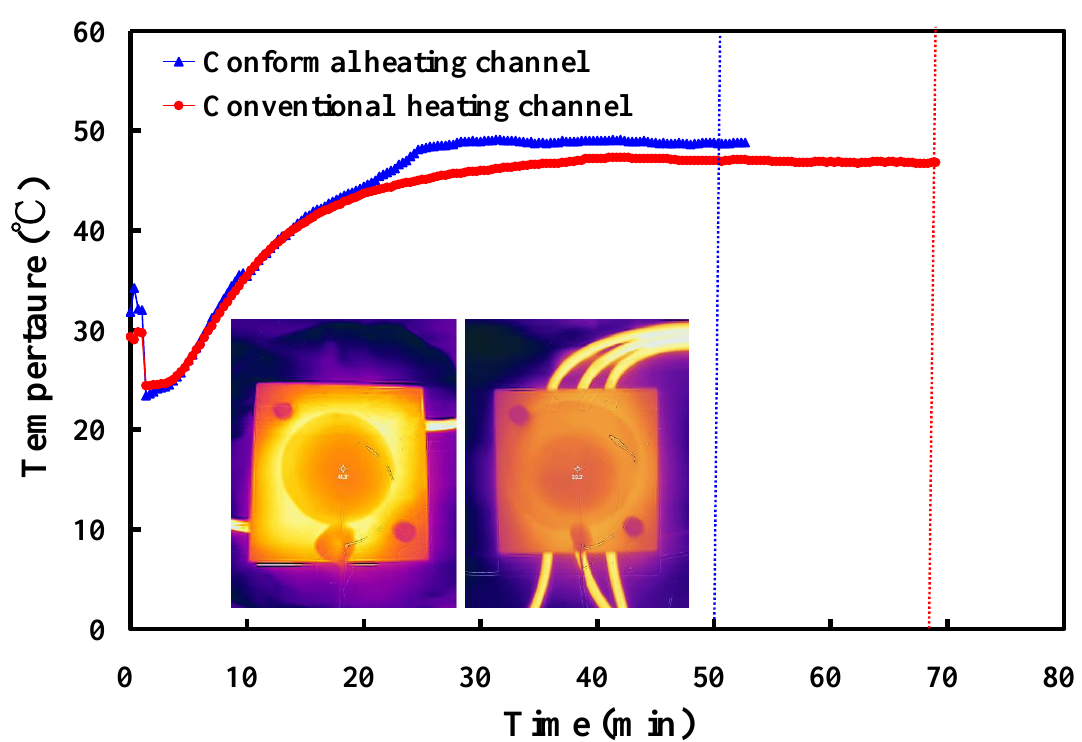
Figure 12. Solidification time of a convex lens for LSR injection mold with CHC and conventional heating channel.